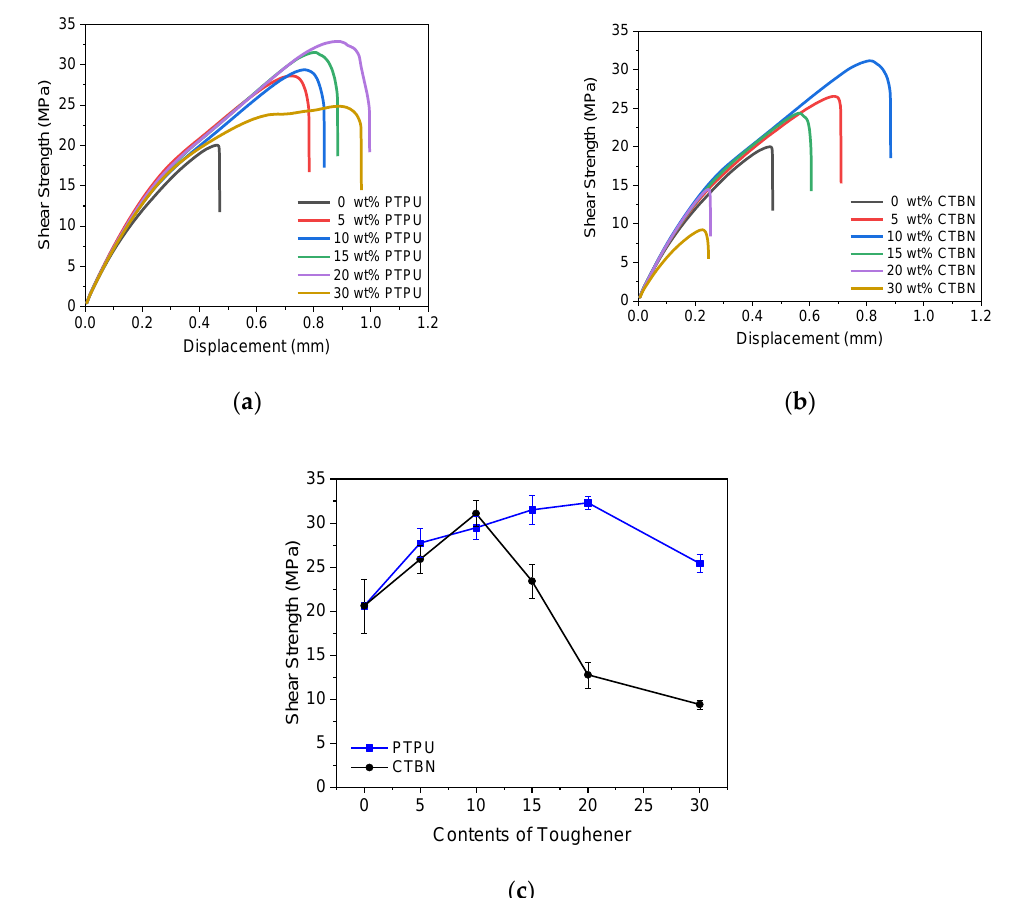
Figure 12. Shear strength-displacement curves of the PTPU- ( a ) and CTBN- ( b ) toughened epoxy adhesives, and comparison of the shear strength of the epoxy adhesives with respect to the toughening agent and its content ( c ).